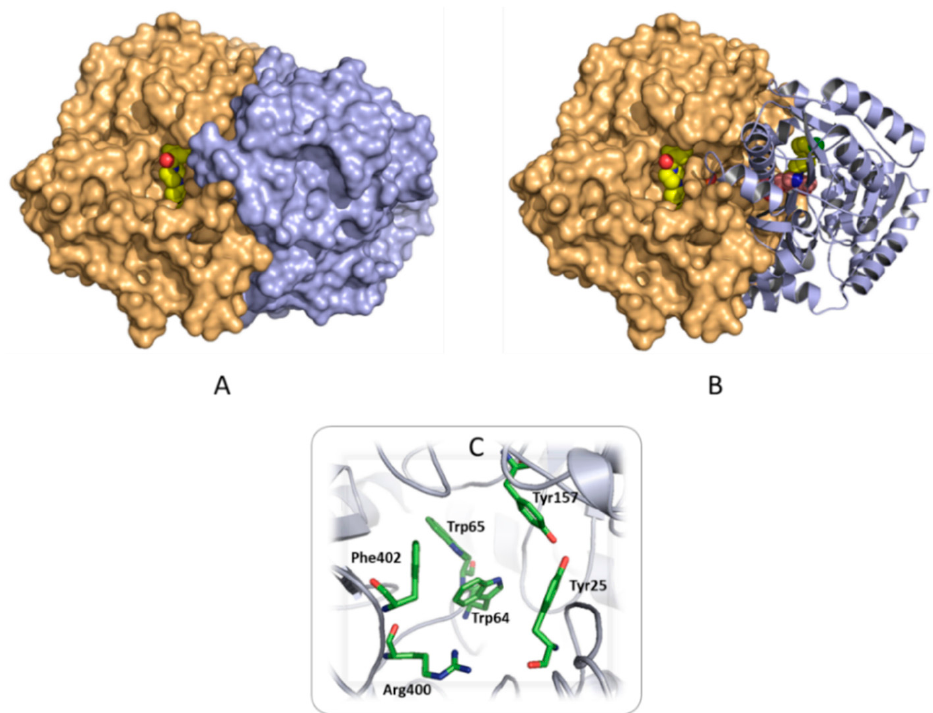
Figure 1. The 3D crystal structure of the Mycobacterium tuberculosis BioA enzyme (PDB code 4XJO). ( A ) Surface representation of the homodimer enzyme. Monomer A is colored light brown, and monomer B is colored light blue. The co-crystallized inhibitors are shown in the CPK representation with carbons colored yellow. ( B ) Same view as in A, in which monomer B is shown in cartoon representation to highlight the location of the two active sites. The PLP molecule is shown in the CPK representation with carbons colored pink. ( C ) Detailed representation of the active site highlighting the main binding residues that are represented as sticks with carbons colored green.